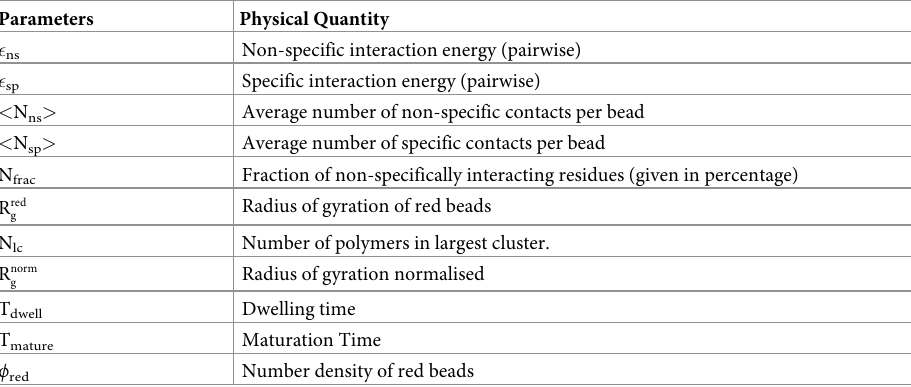
Table 1. Parameters abbreviations in